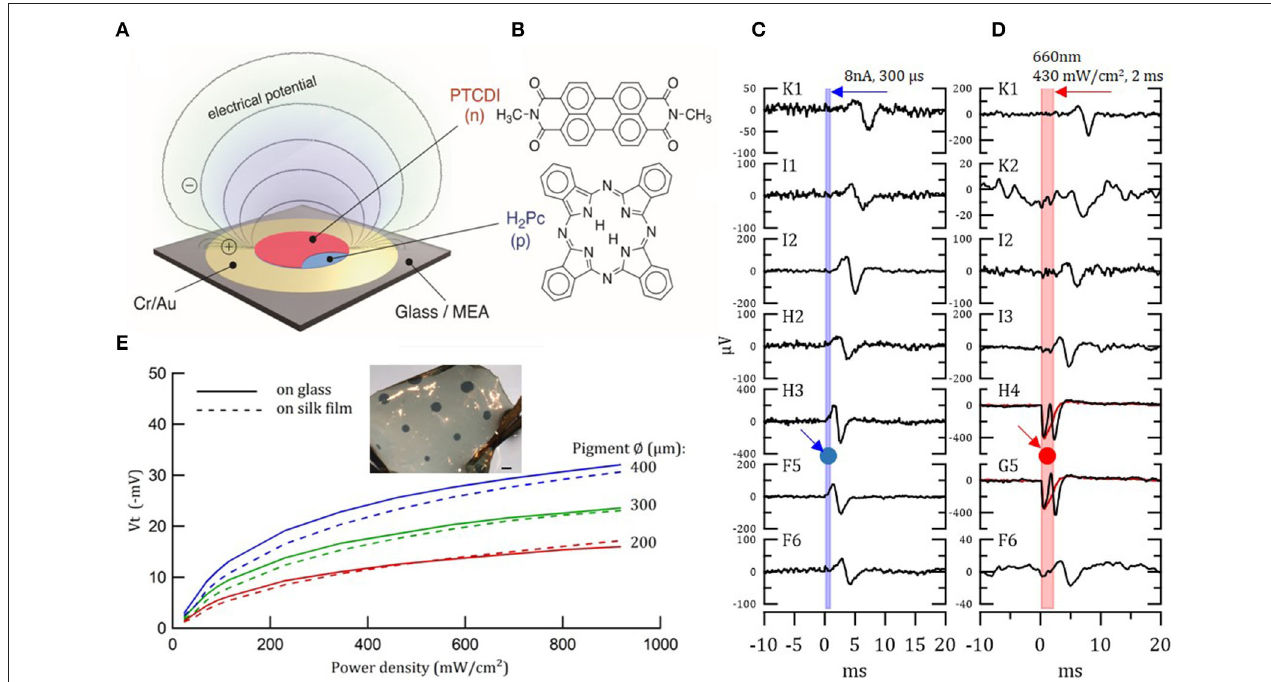
FIGURE 6 | Organic photocapacitor device. (A) Schematic of the photocapacitor device consisting of sequentially evaporated Cr/Au and H2Pc (p-type) and PTCDI (n-type). (B) Molecular structures of the pigment semiconductors. (C,D) Action potential generation in light-insensitive chick embryo retinas in response to current (C) and photoelectrical (D) stimulation, recorded with 30 µ m diameter TiN electrode MEAs. Retina was placed on the MEA/photocapacitor device with ganglion layer facing down. (C) Direct action potential responses in the retina to 8 µ A 300 µ s biphasic current pulse injected to a single electrode of the MEA (G4). Relative location of the stimulating electrode, G4, is marked by a blue arrow and circle. The graphs illustrate the latency of the response, which increases with increased distance from the stimulating electrode. (D) The same as in (C) direct action potential responses in the retina to 660nm 430 mW/cm 2 2ms photostimulation through the x40 microscope objective illuminated from above. Relative location of the illuminated photocapacitor device is marked by a red arrow and circle. Electrodes H4 and G5, which are close to the source, also recorded the electrical signal generated by the device. Reproduced with permission (280). Copyright 2018, Wiley-VCH. (E) Photo-electric responses of illuminated organic photocapacitor pigments on silk film vs. glass deposition. Inset—organic photocapacitor pigments deposited on a silk film. Scale bar − 600 µ m